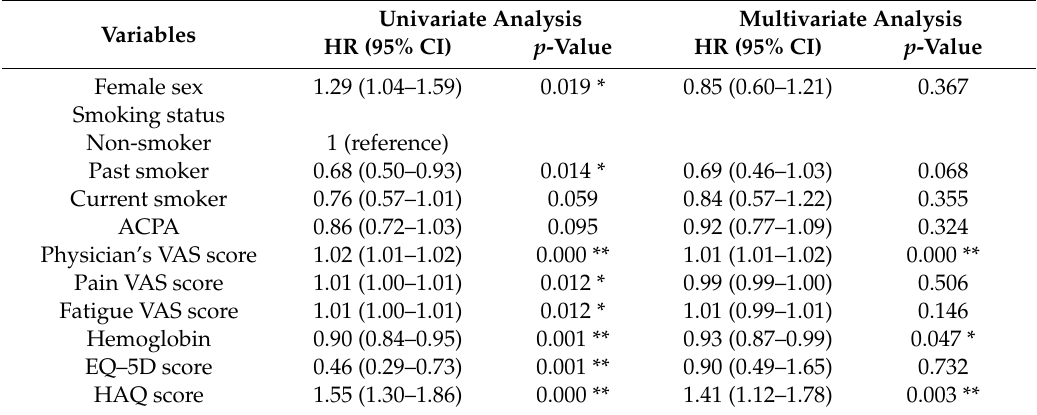
Table 2. Cox proportional hazards model of flares in patients with RA who exhibit low disease activity.